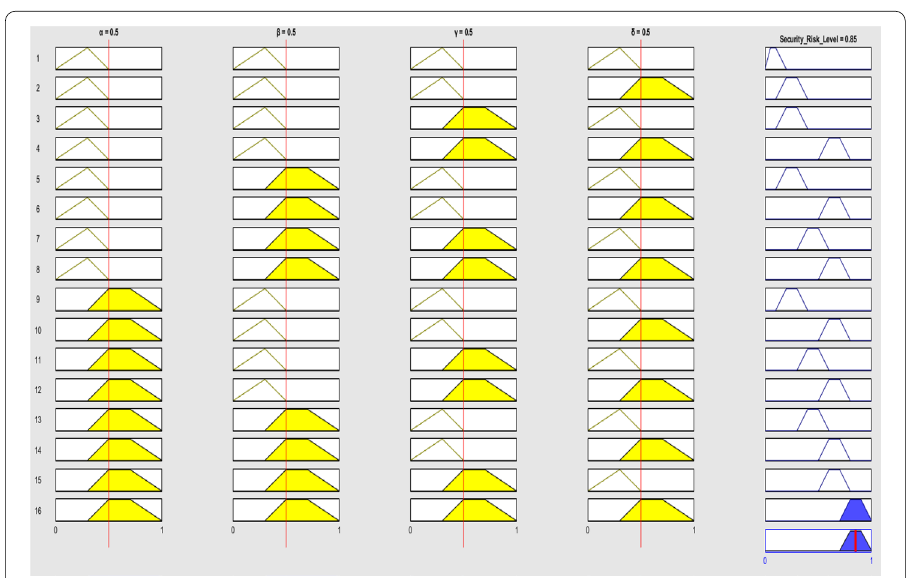
Fig. 5 Rules implementation of the FIS‑based prevention